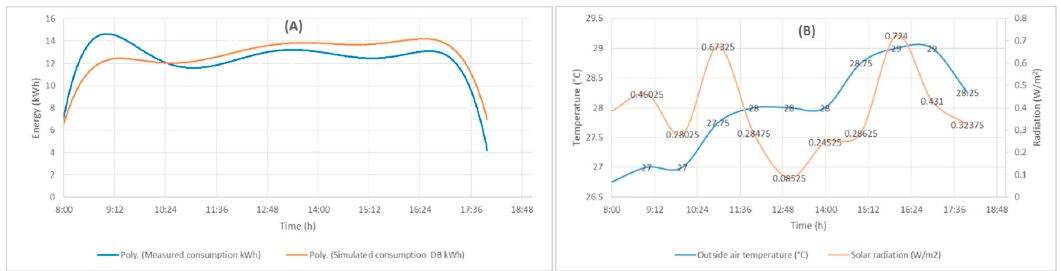
Figure 6. ( A ) Consumption monitored vs. simulated consumption of the Punta Cana building, ( B ) air temperature and solar radiation of the day type studied.